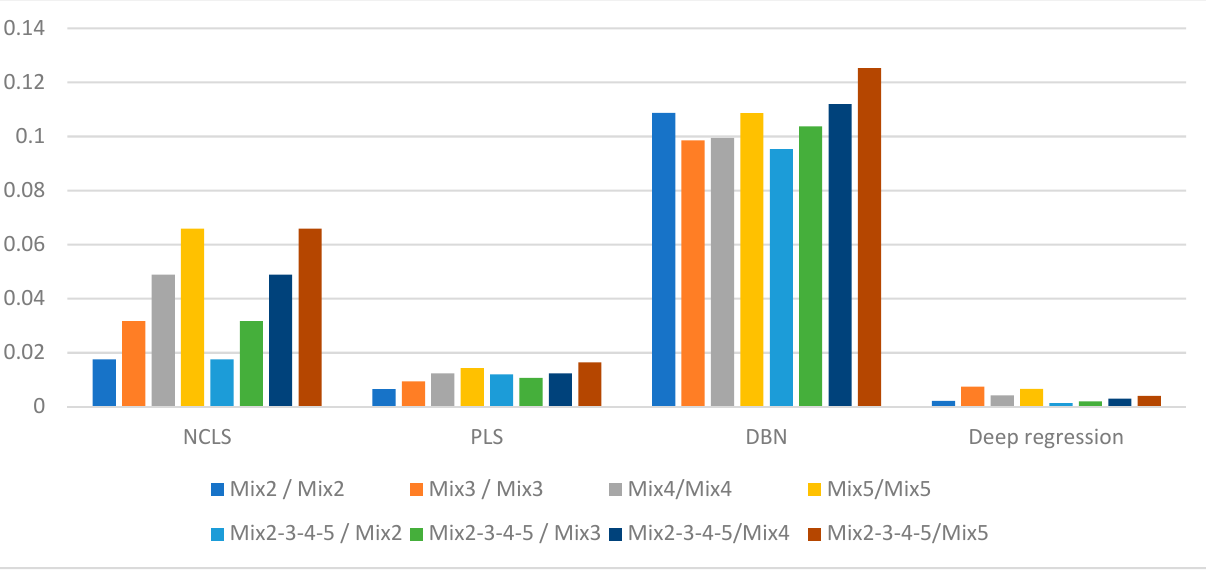
Figure 8. Average RMSE comparison using bar plots for “high ‐ mixing ‐ rate mixture” dataset with respect to method (Mix ‐ ing ‐ rate range used for synthesizing mixtures is: [0.25 3.00], Min: 0.25 Max: 3.00).